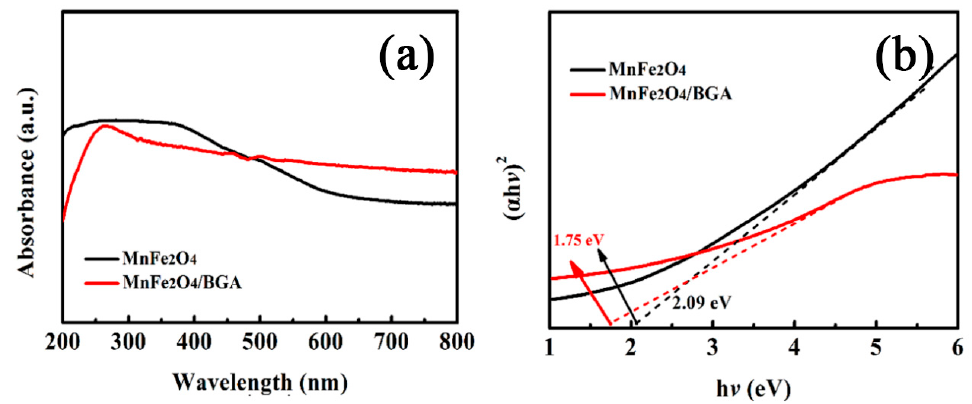
Figure 6. ( a ) UV–Vis DRS spectra and ( b ) the ( α h ν ) 2 versus h ν curves of MnFe 2 O 4 and MnFe 2 O 4 /BGA. 3.2. Degradation of Organic Pollutants on the MnFe 2 O 4 /BGA Composite